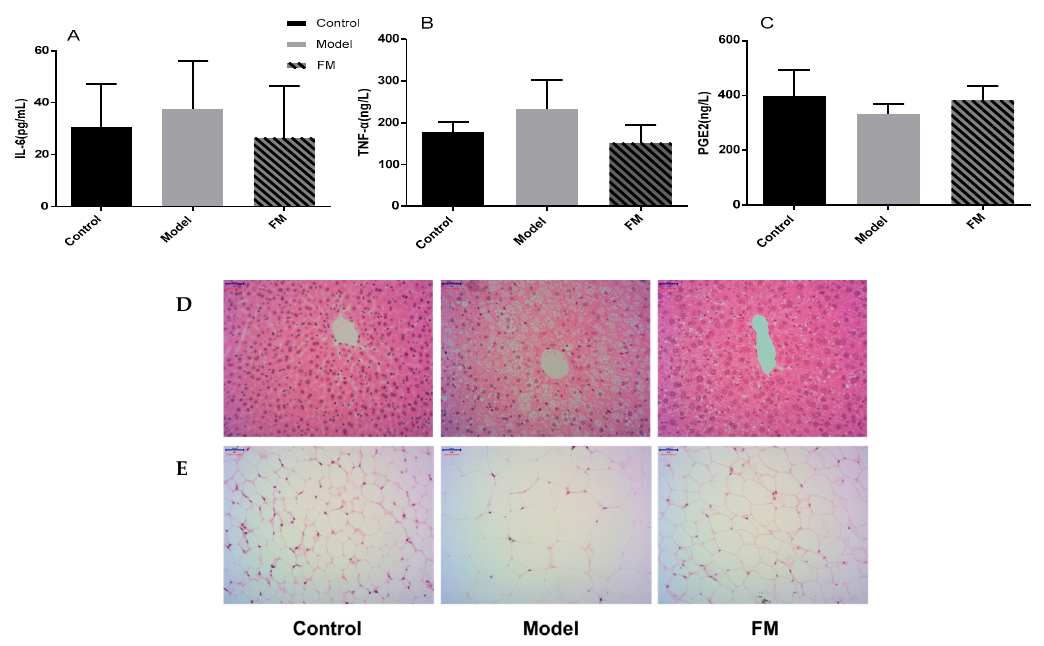
Figure 4. Effects of FM on serum IL-6 ( A ), TNF- α ( B ) and PGE2 ( C ) contents. * p < 0.05 vs. control group. + p < 0.05 vs. model group. Pathological sections of liver tissue ( D ) and epididymal adipose ( E ) in mice (H&E staining × 200).